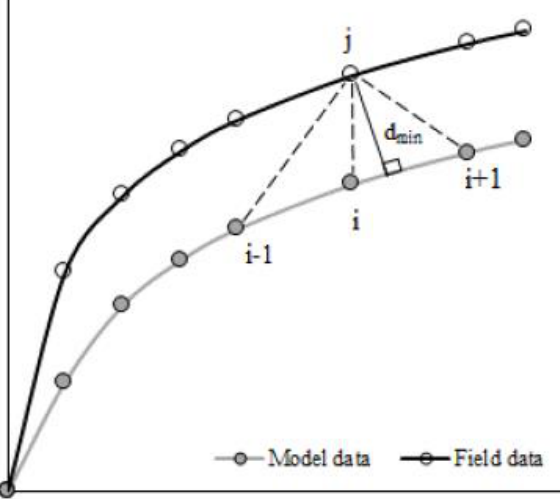
Figure 5. Derivation of a scalar value.